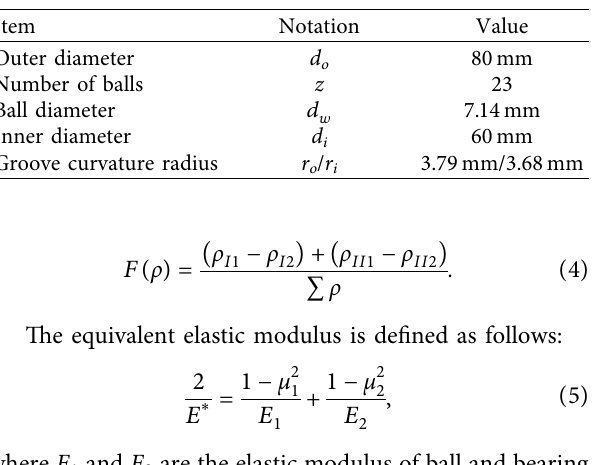
Figure 2: Structural drawing of flexible bearing. Table 1: Structural parameters of flexible